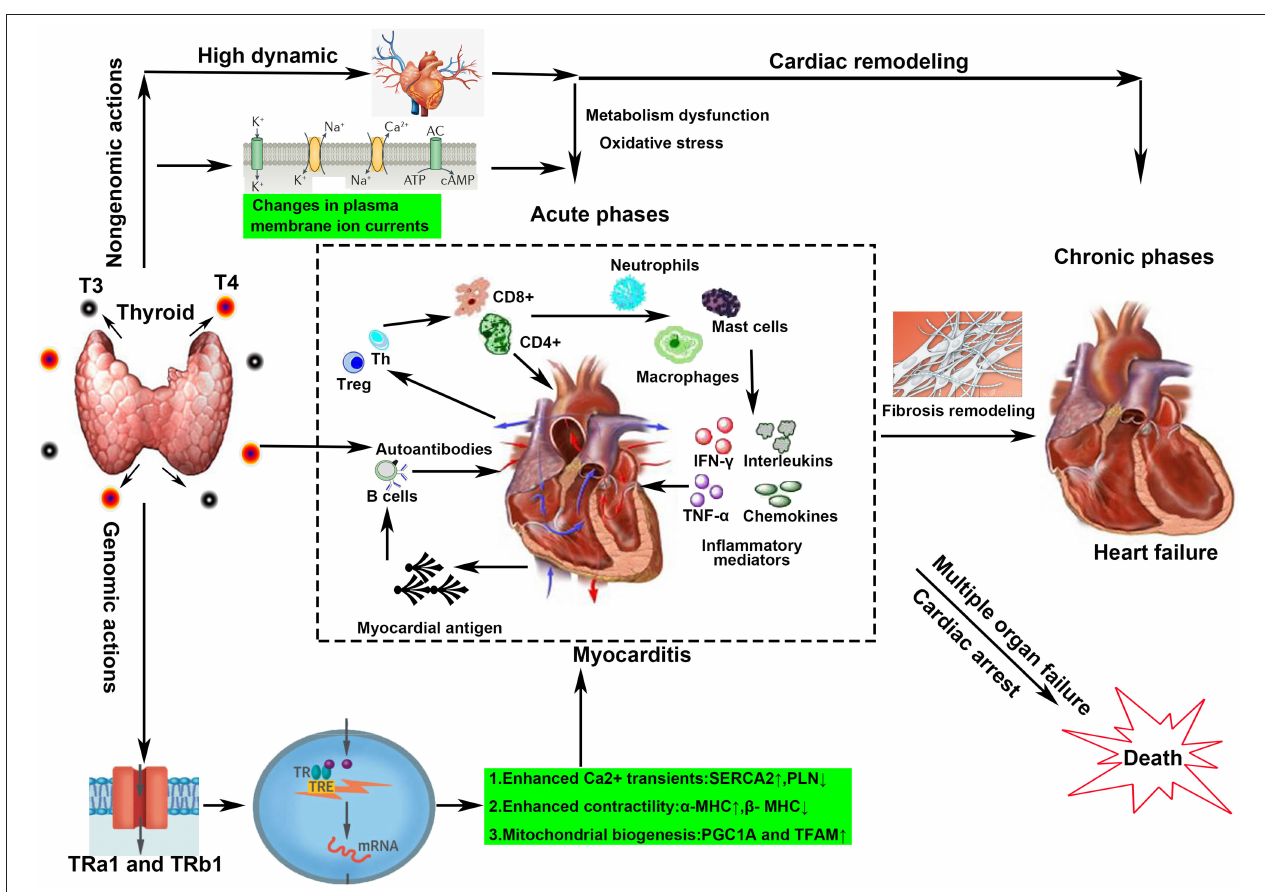
FIGURE 4 | Overview of the possible mechanisms of hyperthyroidism-induced myocarditis. Both genomic and non-genomic actions contribute to the development of Graves’ disease-induced myocarditis. Genomic actions mainly refer to binding to TH response elements in the promoter regions of TH-responsive genes. Non-genomic actions include high dynamic damage, ion channel alteration, and auto-attack from autoantibodies. All lead to a complex cascade of inflammation and sustained destruction of the heart muscle in the acute phases. In the chronic stage, fibrous repair, and structural remodeling are the main